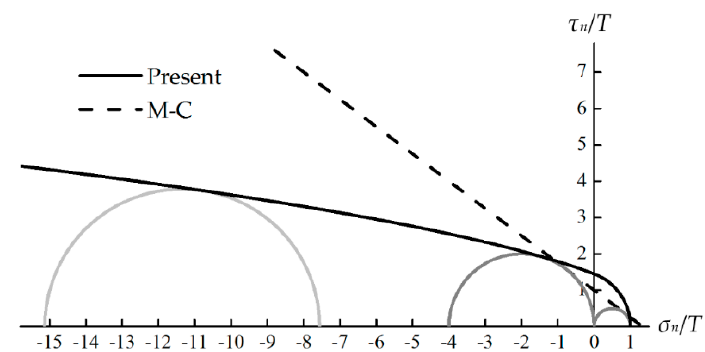
Figure 11. Maximum Mohr’s stress circle under the stress state σ 1 = σ 2 = − σ , σ 3 = − 2 σ . C / T = 4, θ T = 90.0°, and θ C = 37.0°.